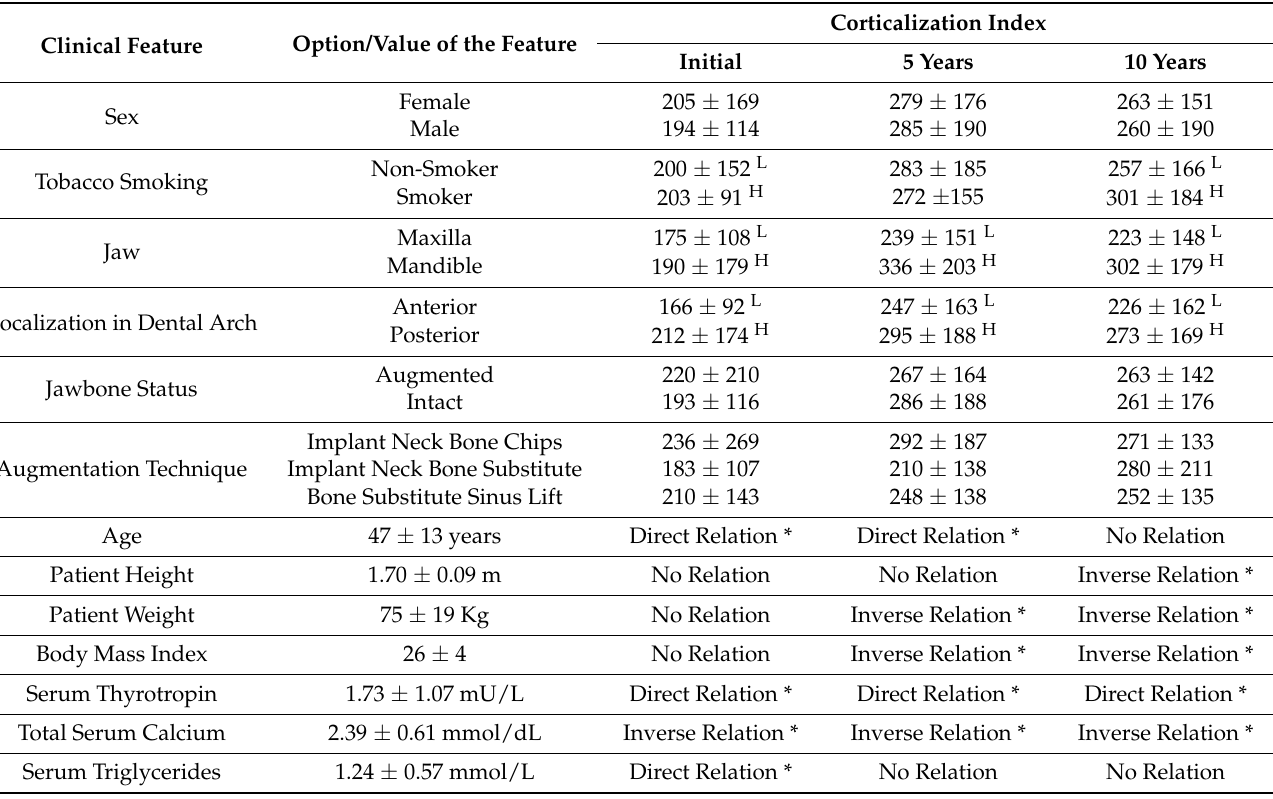
Table 3. Presentation of included population. Assessment of the impact of baseline epidemiological data on the corticalization index observed in peri-implant bone.